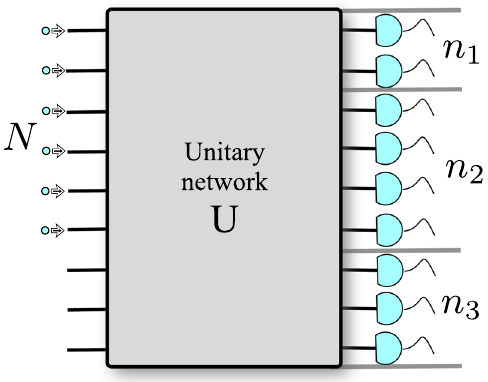
Figure 1. Unitary network with the output ports grouped into bins. A quantum network, having a unitary matrix U , with N indistinguishable identical particles at its input and binned-together output ports (three bins in this case). We are interested in the probability of counting n = ( n 1 , n 2 , n 3 ) particles in the output bins. (Two or more bosons as well as classical particles may share the same input